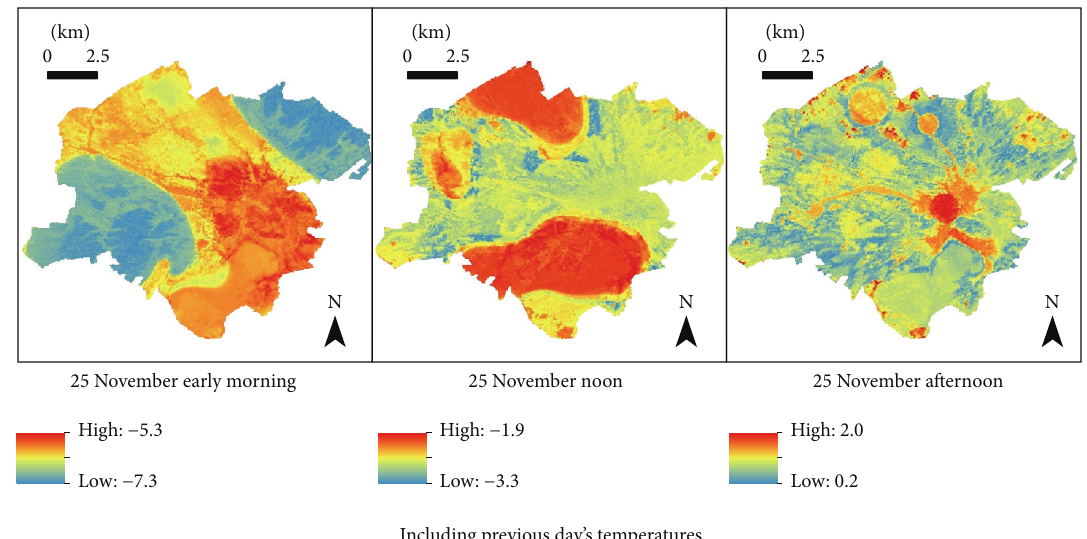
Figure 16: Autumn estimated temperatures ( ∘ C) for three different time periods on 25 November 2013—early morning, around noon, and